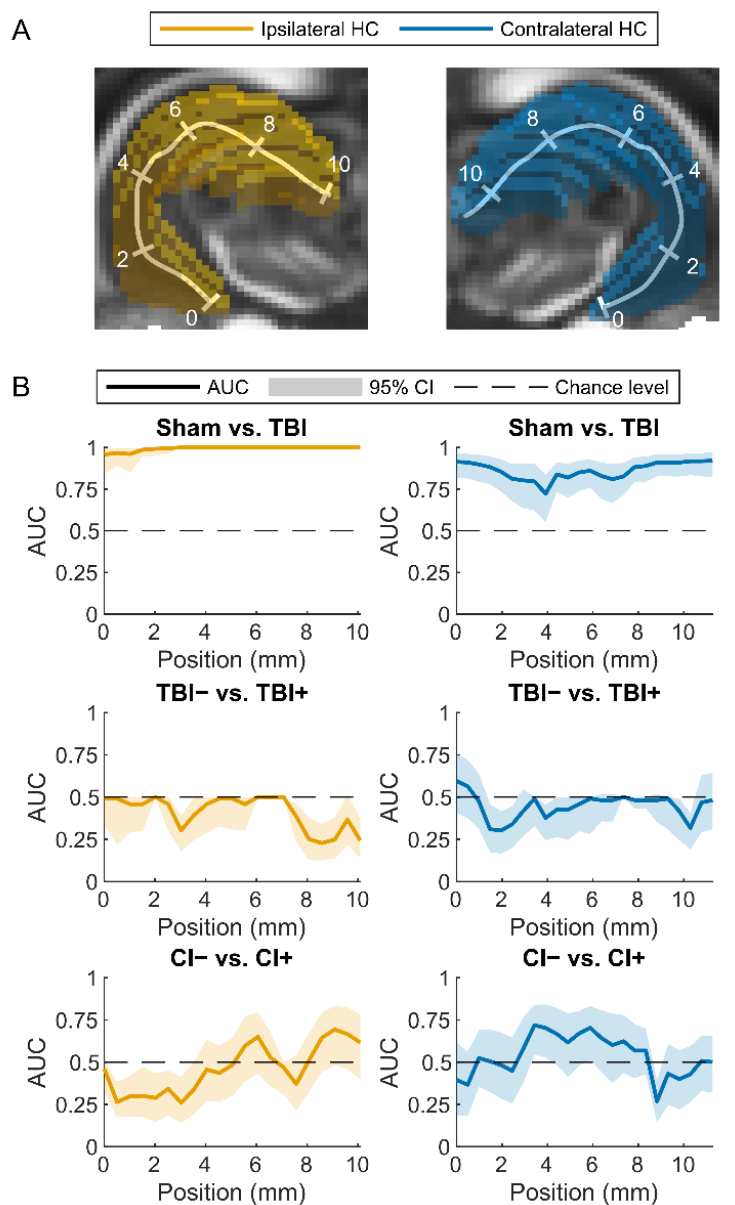
Figure 6. Classification performance of the elastic net-regularized logistic regression models. ( A ) Locations of analysis points along the ipsilateral (left, yellow) or contralateral (right, blue) hippocampus (HC). ( B ) Cross-validated area under the receiver operating characteristic curve (AUC) and its 95% confidence interval (95% CI) for different classification tasks: sham vs. TBI (traumatic brain injury), animals without (TBI − ) or with (TBI+) epilepsy and rats without (CI − ) or with (CI+) cognitive impairment. MRI parameters assessed in the ipsilateral hippocampus resulted in an almost perfect classification between the sham and TBI animals. The abnormalities in the temporal and septal ends of the contralateral hippocampus also resulted in an excellent separation of the sham from the TBI animals. Instead, ipsilateral or contralateral hippocampal abnormalities did not differentiate between the TBI − and TBI+ groups. Interestingly, the abnormalities in the contralateral hippocam- pus located at levels 3.4, 3.9, and 5.9 mm from the temporal end resulted in a lower bound of the confidence interval of AUC higher than 0.5 (AUC at 3.4 mm 0.72 with confidence interval 0.55–0.85, AUC at 3.9 mm 0.70 with confidence interval 0.53–0.84, AUC at 5.9 mm 0.70 with confidence interval 0.52–0.84), indicating that it may be possible to differentiate between animals without (CI − ) and with (CI+) cognitive